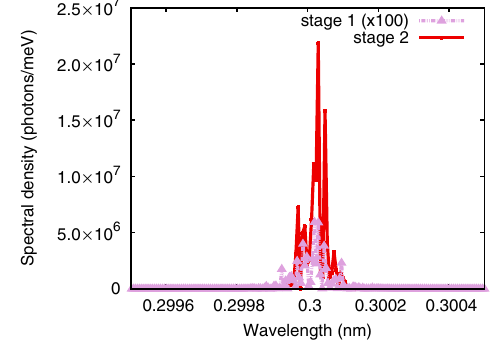
FIG. 4. Spectrum of the 4 keV part of the radiation for the nominal example at end of stage 1 (scaled up by a factor of 100) and at the end of stage 2. The tuning of the two stages must be adjusted in order to center the spectra around the same